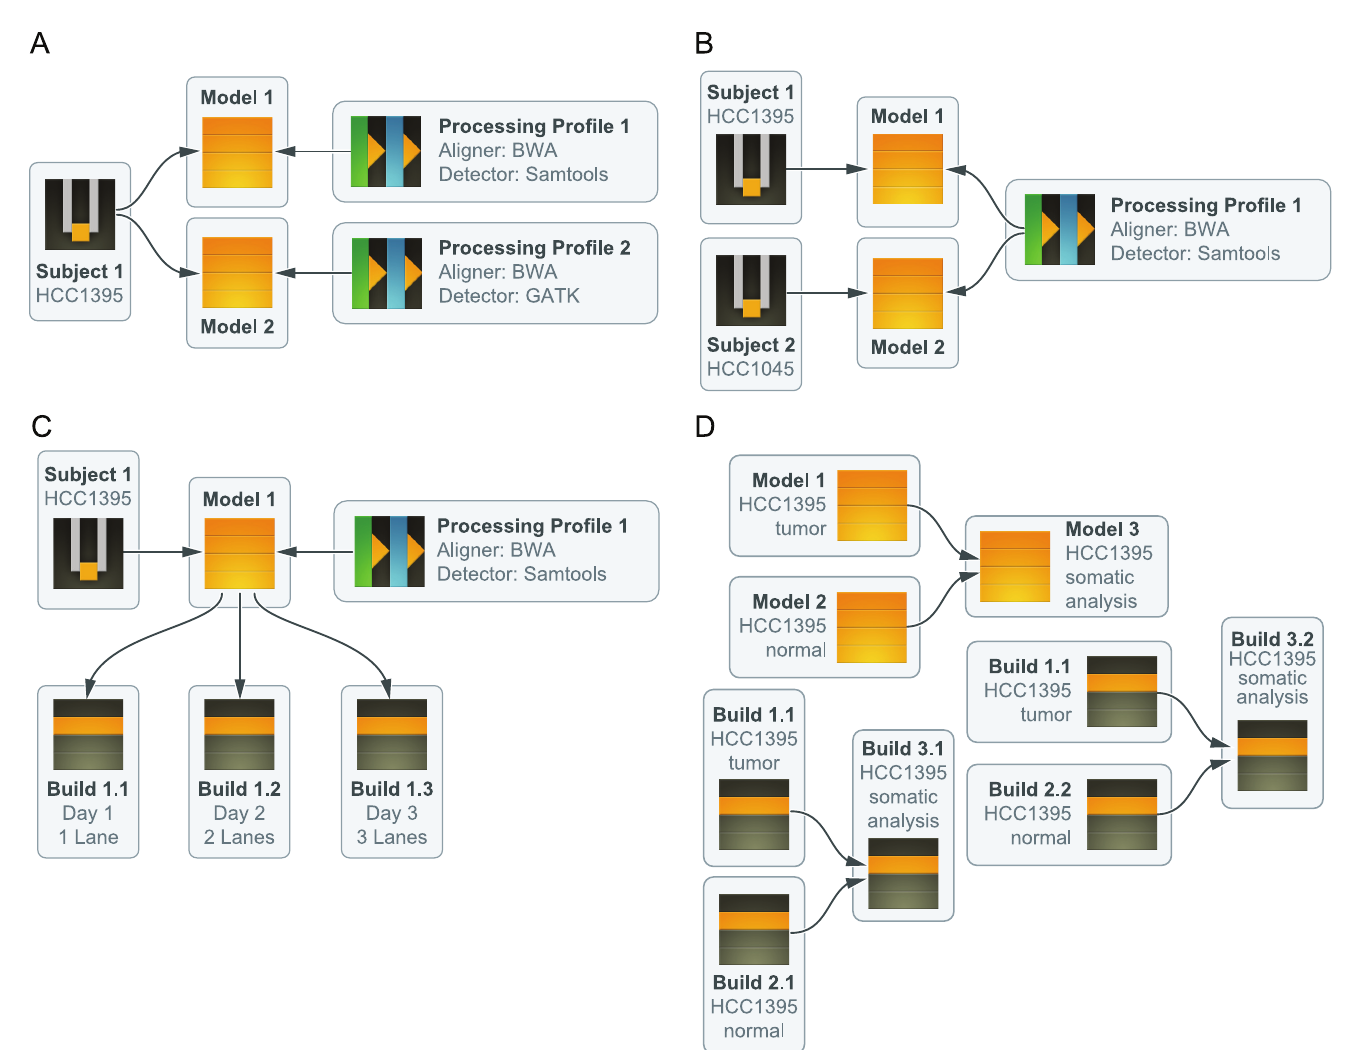
Fig 2. Key concepts of the GMS. The genome modeling system is architected around the idea of a ‘ genome model ’ . The following vignettes illustrate key concepts integral to these models: ( A ) A subject can be modeled multiple times, possibly each with distinct ‘ processing profiles ’ . For example, two different models can be defined for the HCC1395 genome using the ‘ reference alignment ’ pipeline. In Model 1, the processing profile specifies the use of BWA for alignment and Samtools for variant detection. In Model 2, Bowtie2 and GATK are used for these steps instead. ( B ) A given processing profile can be used across a group of models, ensuring, for instance, that all subjects in a cohort are processed in similar ways. In this example, two different cell line genomes (HCC1395 and XY2123) have models defined of the exact same type, using the processing profile with BWA/Samtools specified. ( C ) A model has no results until a build is generated. If the model is updated to have new inputs, a new build is required. Builds are immutable snapshots of modeling pipeline results. In this example, the HCC1395 genome has a reference alignment model again making use of the BWA/Samtools profile. However, as new instrument data becomes available, new builds are constructed to reflect the most complete data. ( D ) When models are used as inputs for other models, the last complete build for the input model is used as an input for the downstream build. In this example, both tumor and normal genomes are available for an individual (in this case HCC1395). Reference alignment models are built for each sample and then both are used as inputs for a third ‘ somatic variation ’ model. In reality, it is the underlying data in the reference alignment builds that are used to create a somatic variation build, identifying all variants that are thought to be tumor